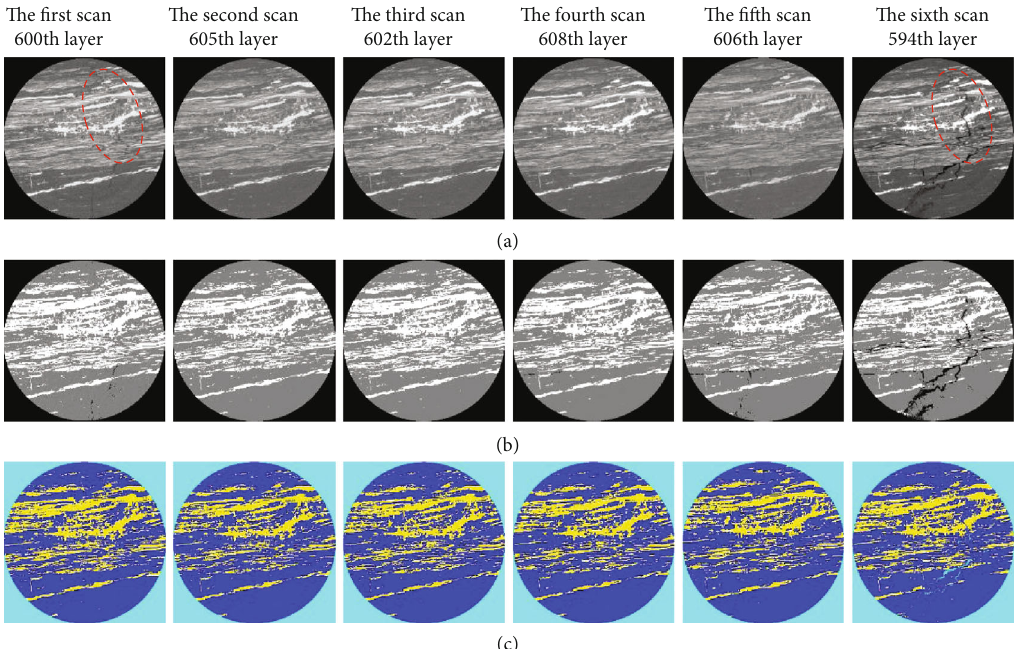
Figure 9: The processing results of CT images.